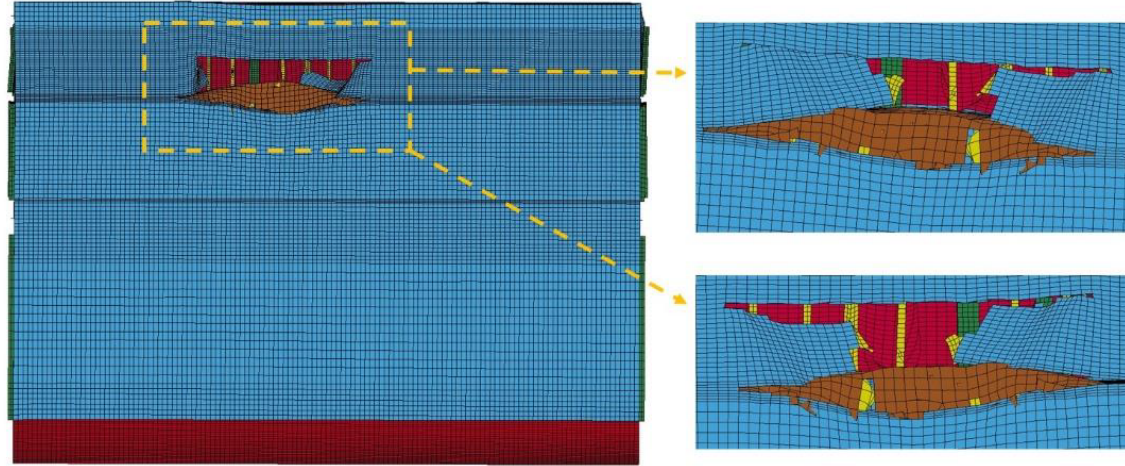
Figure 18: Deformation on DSS outer skin after collision on outer skin structure – 1.